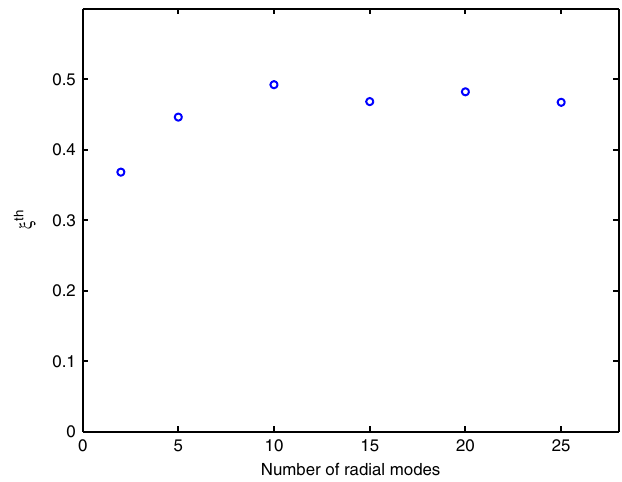
FIG. 7. Threshold of microwave instability as a function of number of radial modes expanding with the Laguerre